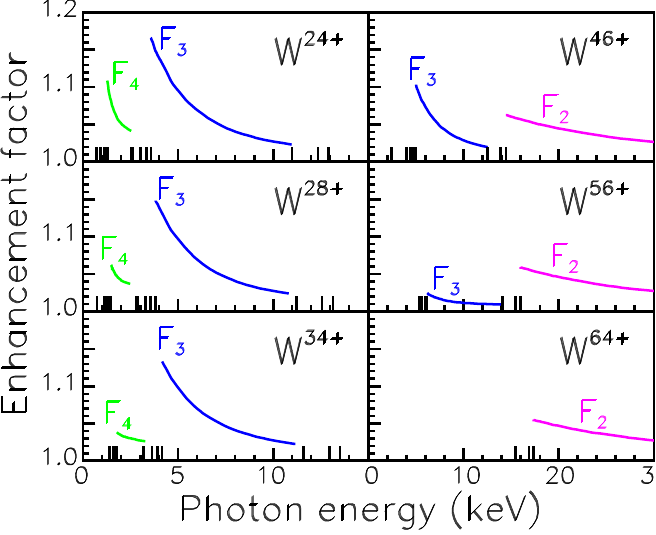
Figure 8. Enhancement factors F captured in the lowest state. Green, F ionization